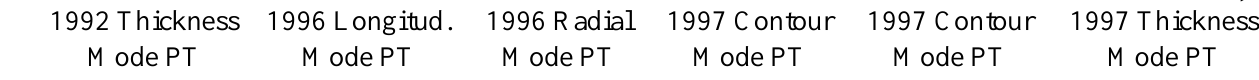
Figure 19. The state of the art of power piezoelectric transformers (PTs) technology (courtesy of Micromechatronics, Inc.).